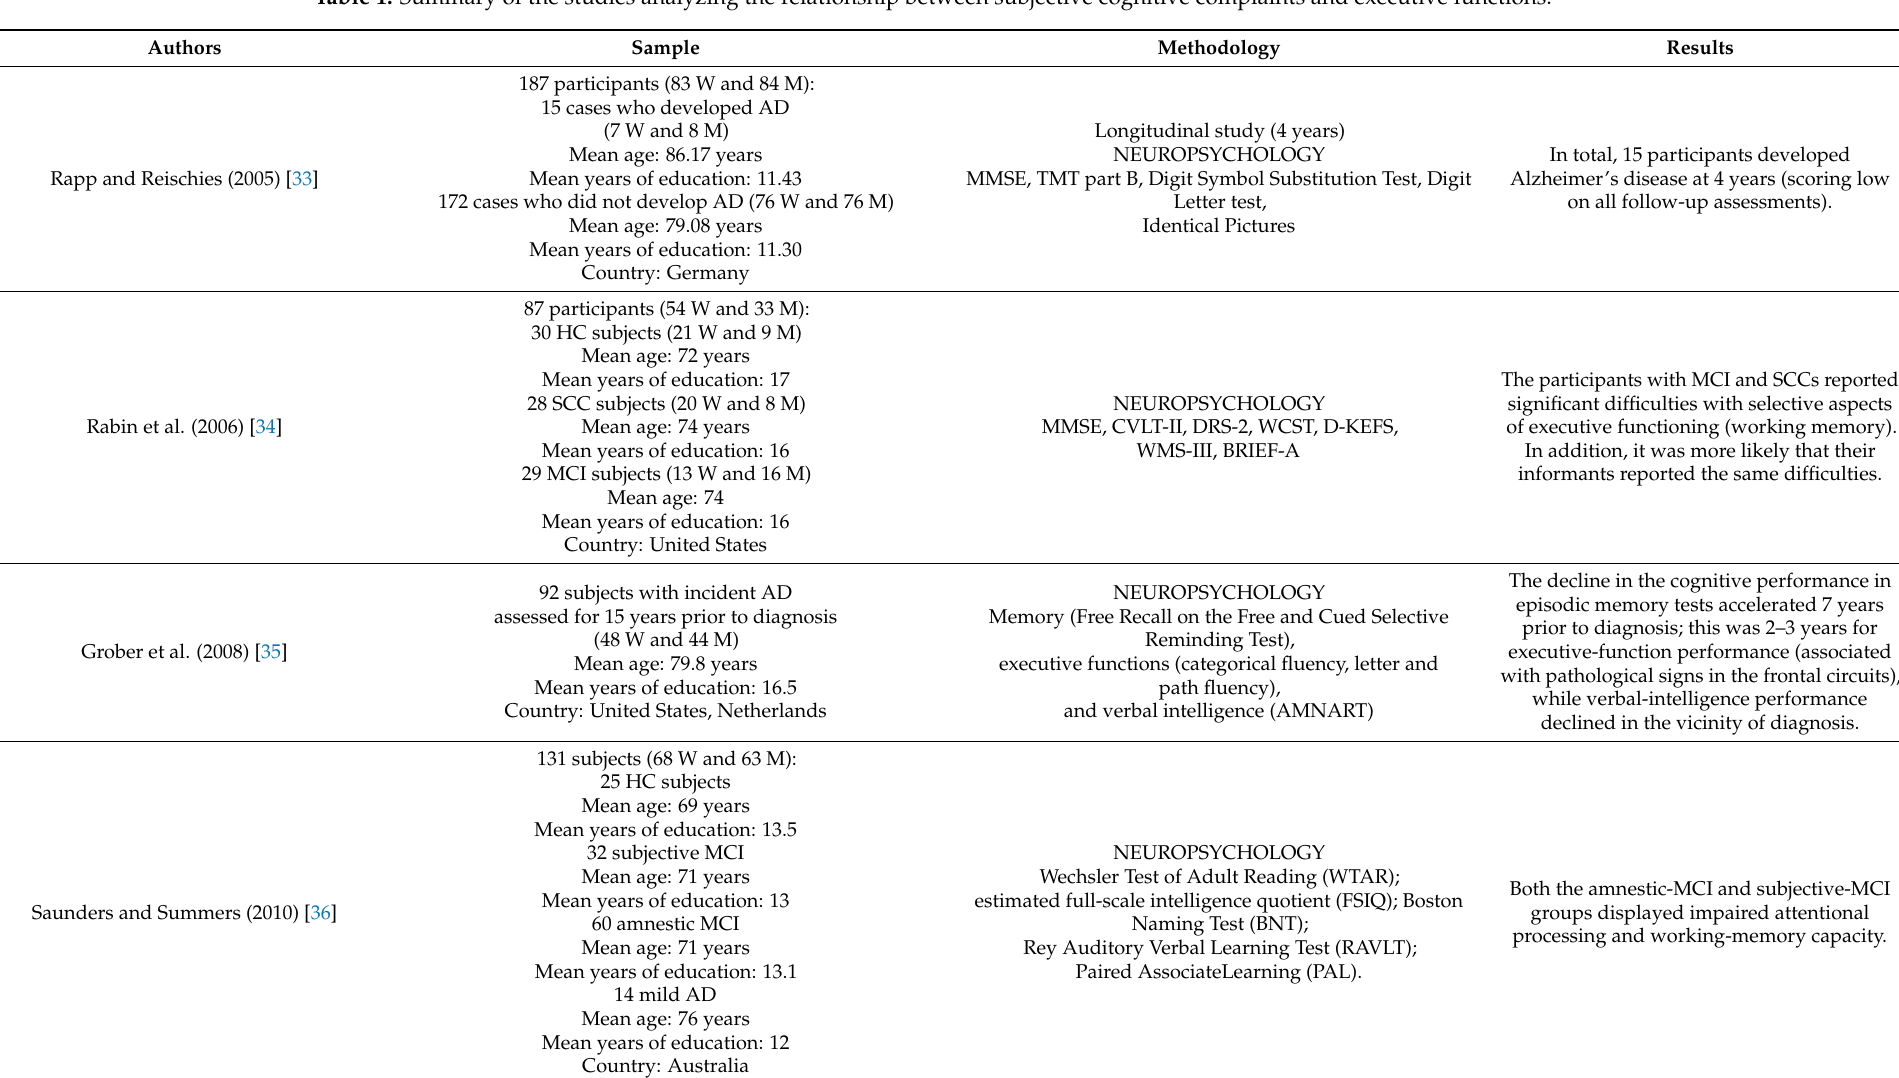
Table 1. Summary of the studies analyzing the relationship between subjective cognitive complaints and executive